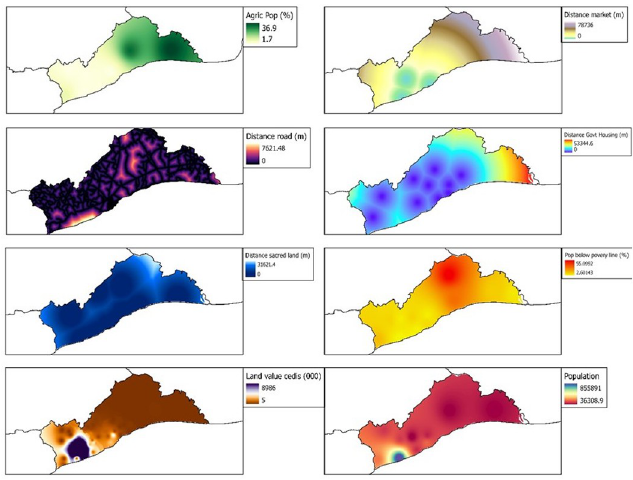
Fig 3. Anthropogenic variables of land cover change in the Greater Accra Region. Source: [36].